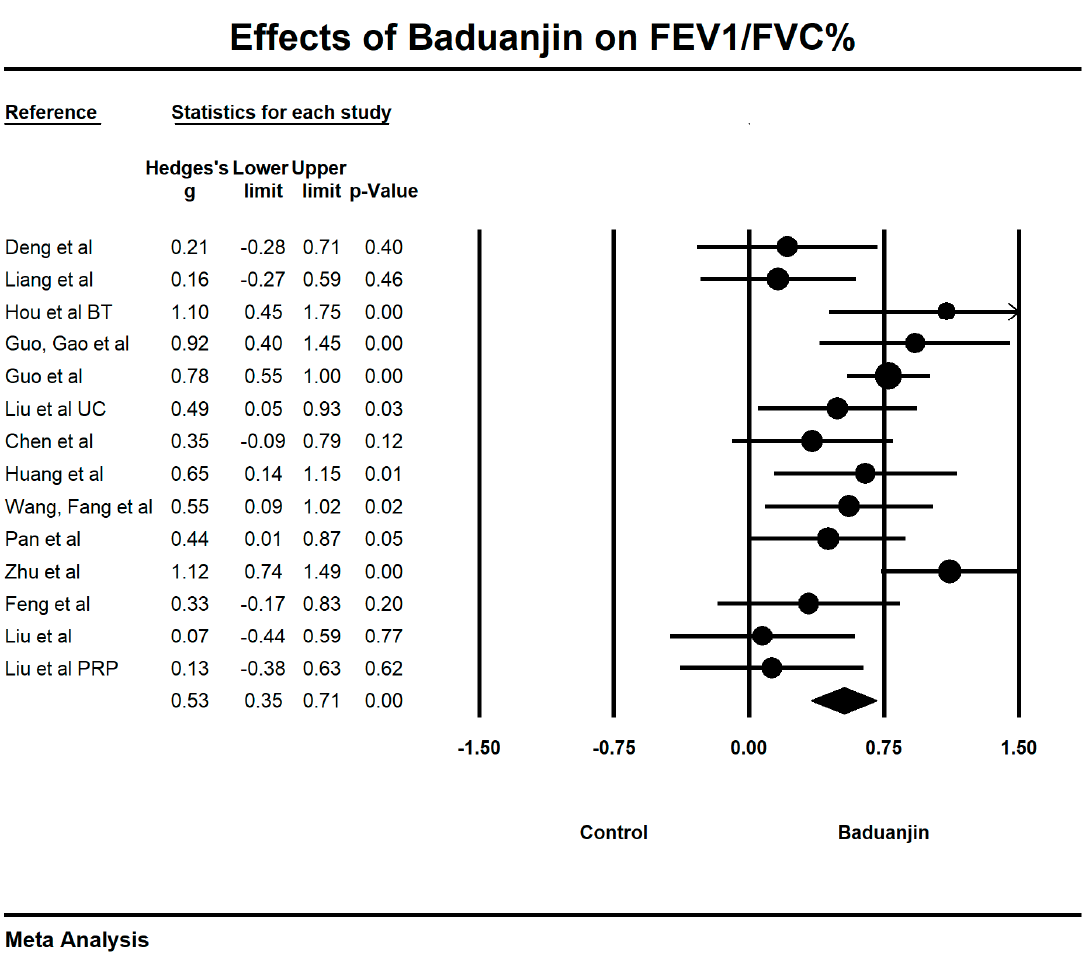
Figure 10. Funnel plot of publication bias for FEV 1 /FVC%.